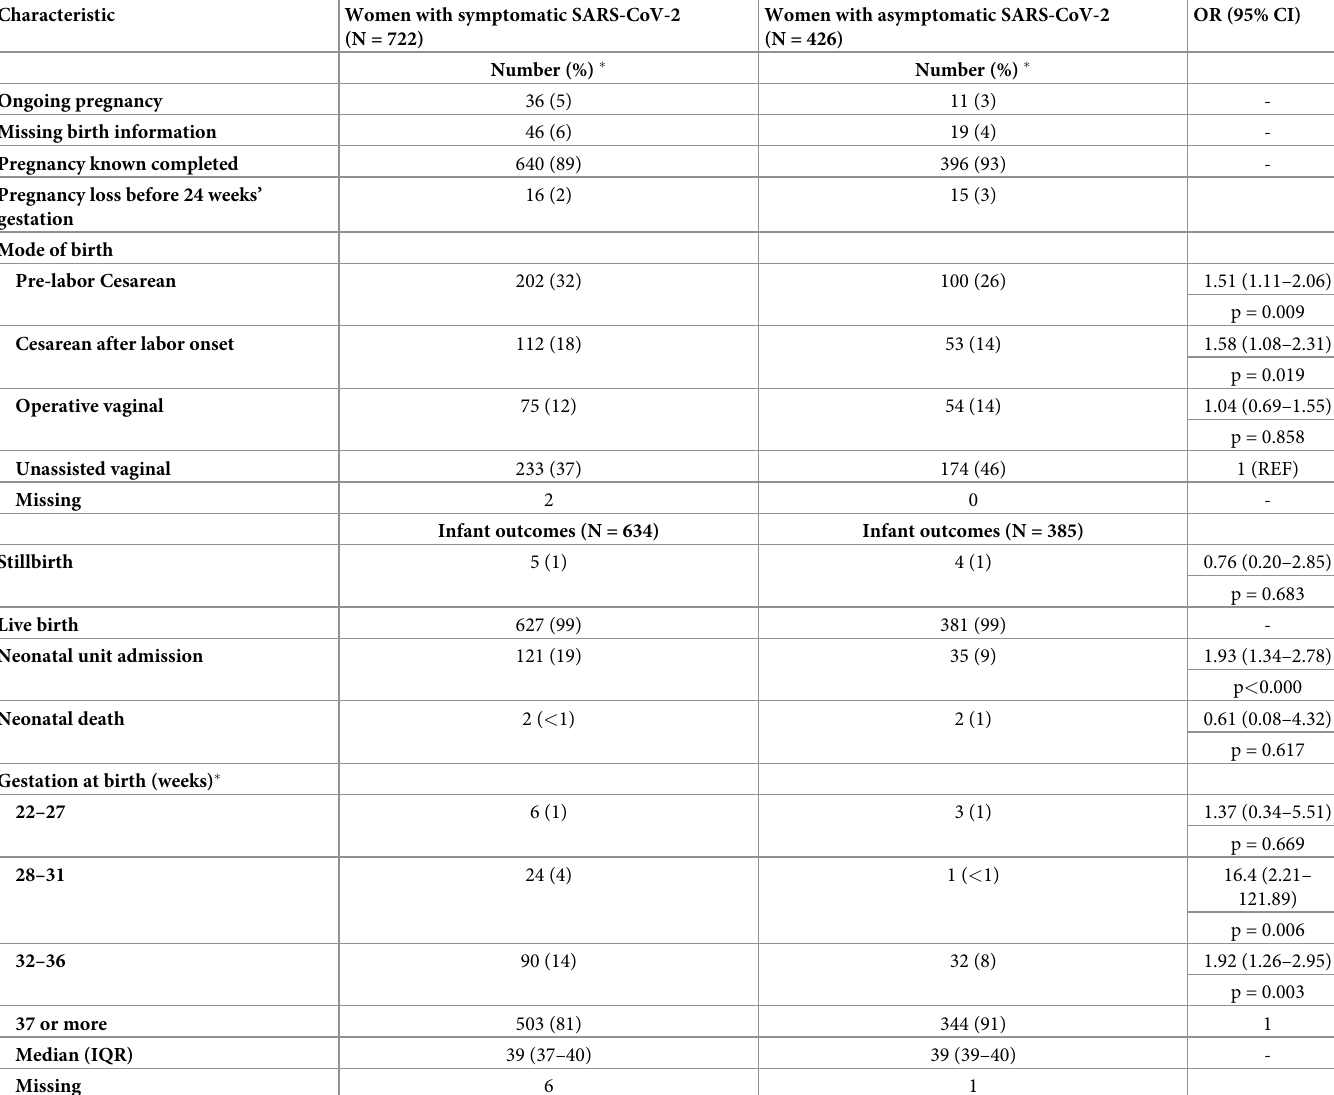
Table 4. Pregnancy and infant outcomes for symptomatic versus asymptomatic SARS-CoV-2 in pregnant women hospitalized in the UK. Characteristic Women with symptomatic SARS-CoV-2 (N =